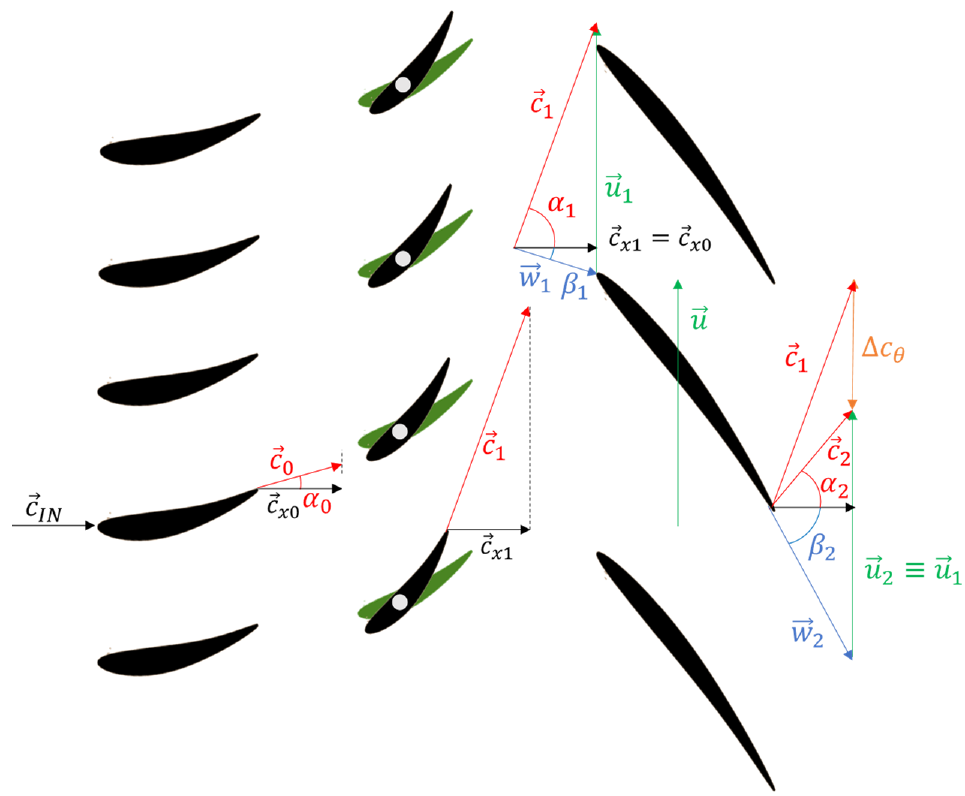
Figure 4. Guide vane and rotor blade profiles in the meanline blade-to-blade plane and flow velocity triangles at off-design conditions ( k u = 1, simple guide vane regulation)—flow rate reduced.